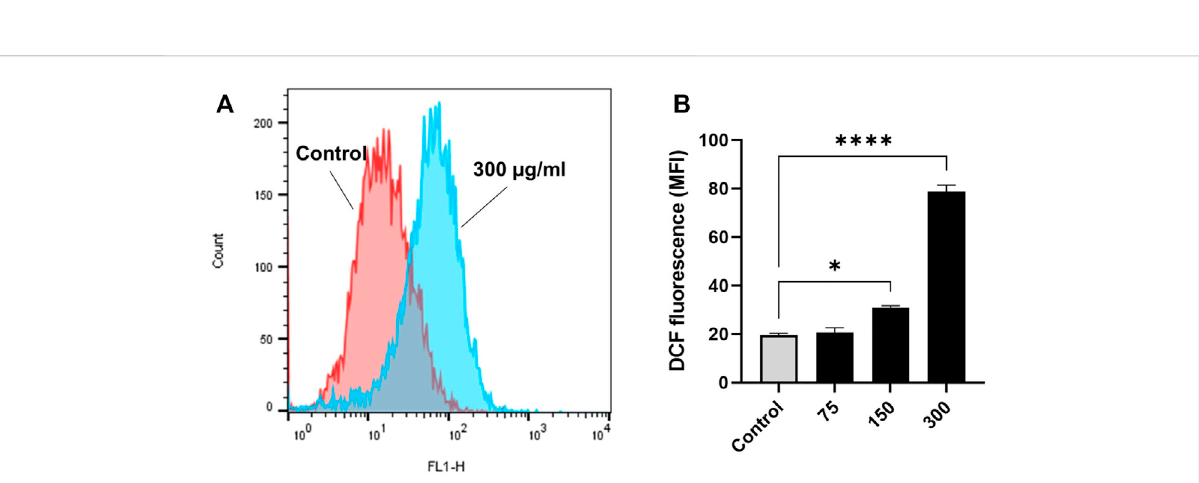
FIGURE 5 Ethanol extract of Colligonum comosum (EECC) causes oxidative stress in MCF-7 cells. MCF-7 cells were treated for 48 h with indicated concentrations of EECC. Cells were analyzed for DCF fl uorescence (ROS generation) after having been stained with DCFDA. * p < 0.05, *** p < 0.0001 vs. control. Data represent mean ± SD of